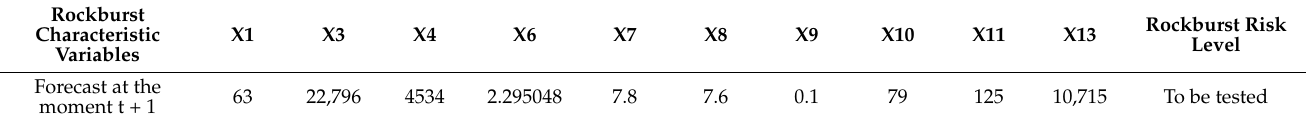
Table 4. Rockburst characteristic variable prediction at time t + 1.